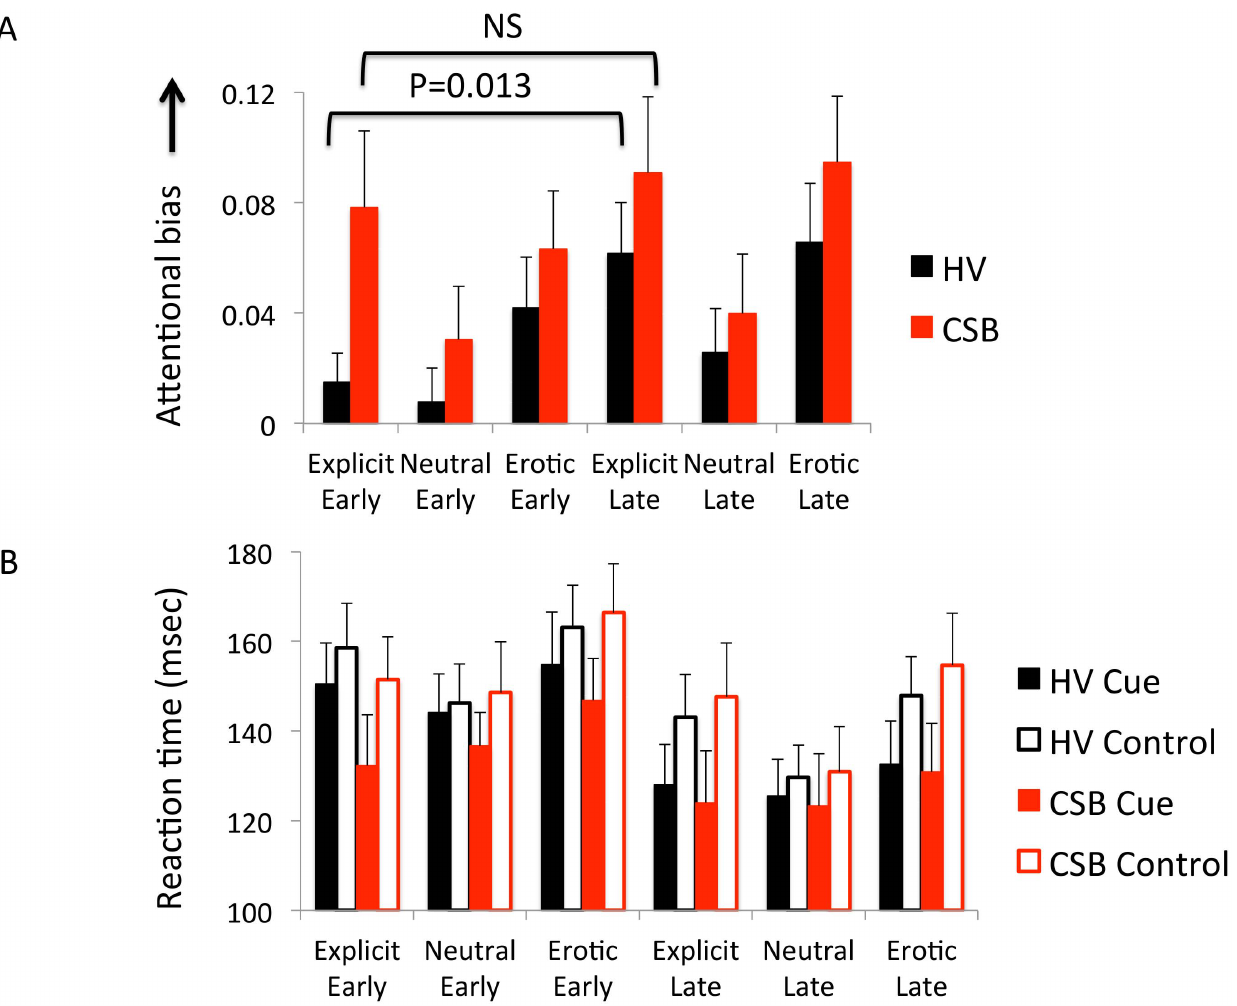
Figure 2. Stimulus latency and raw reaction time scores. A. Stimulus latency. The attentional bias score is shown for subjects with compulsive sexual behavior (CSB) and healthy volunteers (HV) as a function of stimulus latency (Early: 250–350 msec; Late 350–450 msec). B. Raw reaction time for cues and control stimuli for CSB and HV subjects. The error bars represent standard error of the mean.